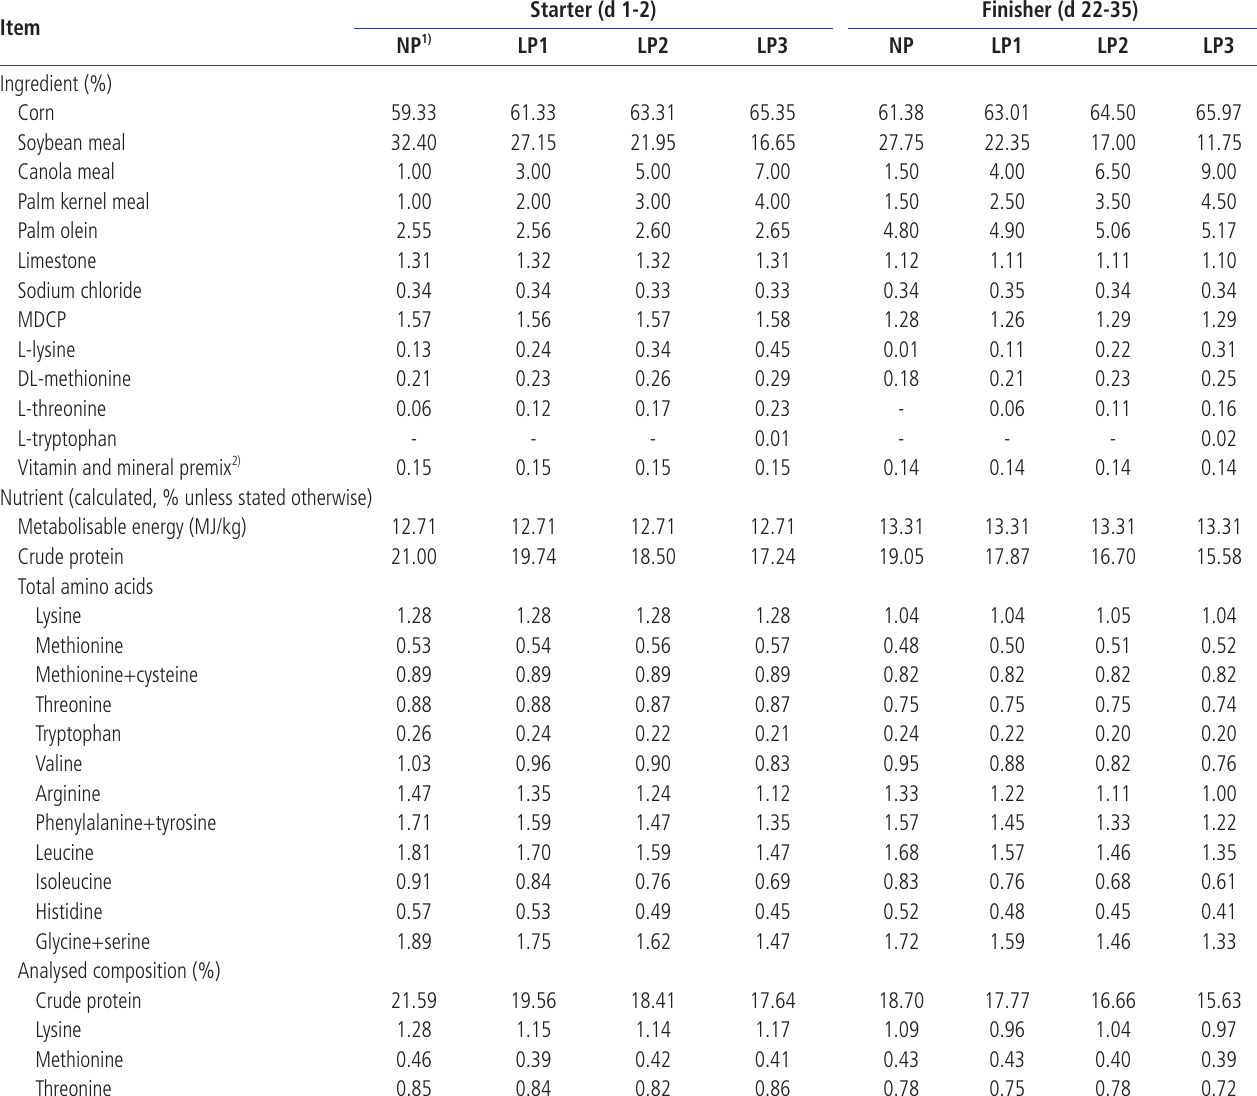
Table 1. Ingredient and nutrient compositions of experimental